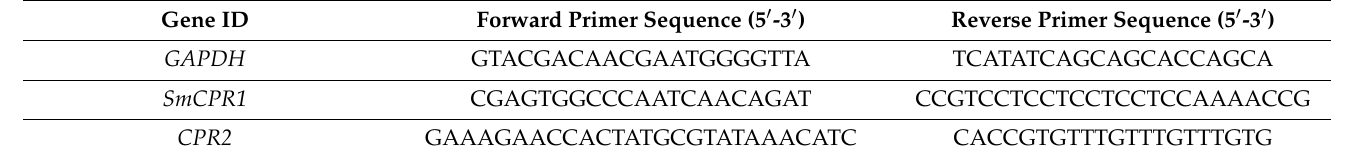
Table 1. The primer sequences for qRT-PCR.